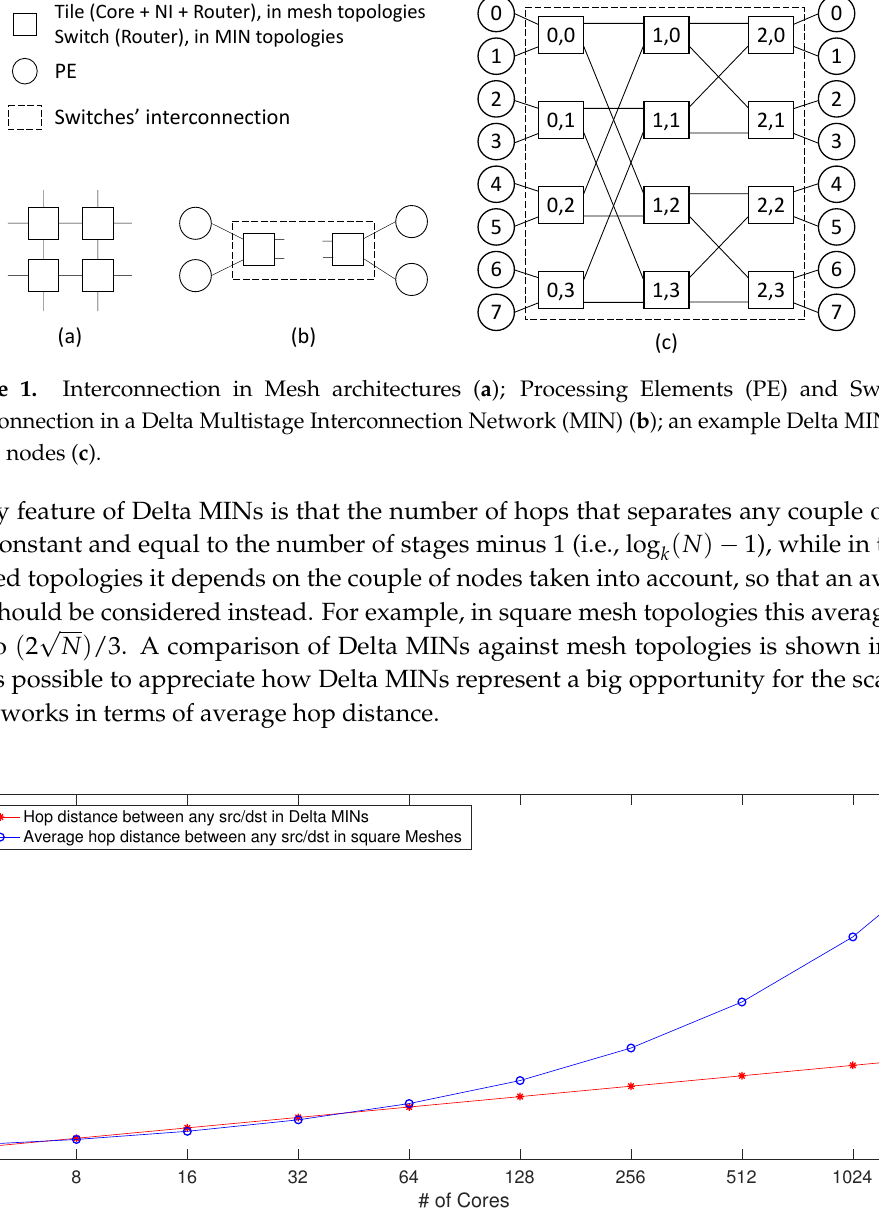
Figure 2. Average hop distance in Delta MIN topologies and Mesh topologies for an increasing number of